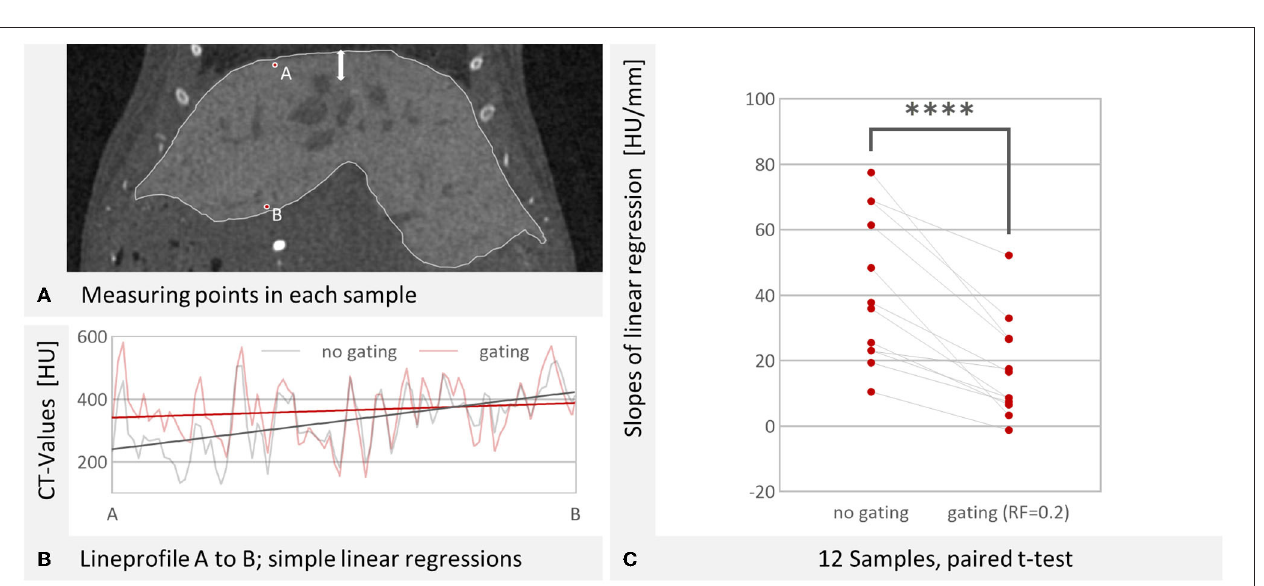
FIGURE 7 | Evaluation of line profiles. (A) Start- and endpoint for the evaluated line profile. The breathing results in a motion of the lungs and liver as shown by the white arrow. Image reconstructed with RF = 0.2. W: 4,014 HU L: 668 HU (B) Lineprofile from point A to point B. Linear show a steeper slope without gating (25.5 HU/mm) than with gating (6.5 HU/mm). The lineprofile covers 7.2mm. (C) The slope is significantly reduced by gating (for RF = 0.2, n = 12, p < 0.0001 as indicated by ****, paired t